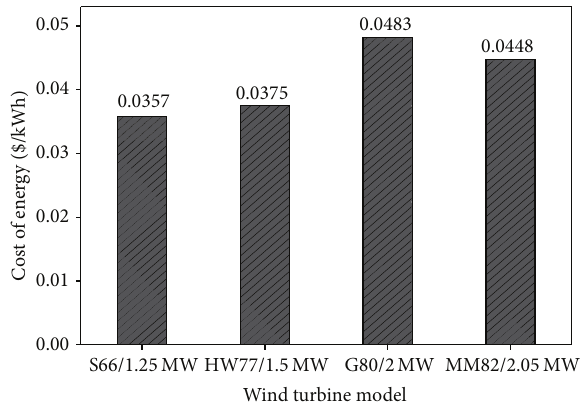
Figure 9: Cost of energy ( 𝐶 ) produced by selected wind turbines in terms of